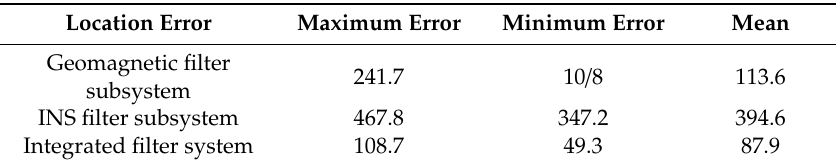
Table 1. Results of simulation experiment (Unit: m).